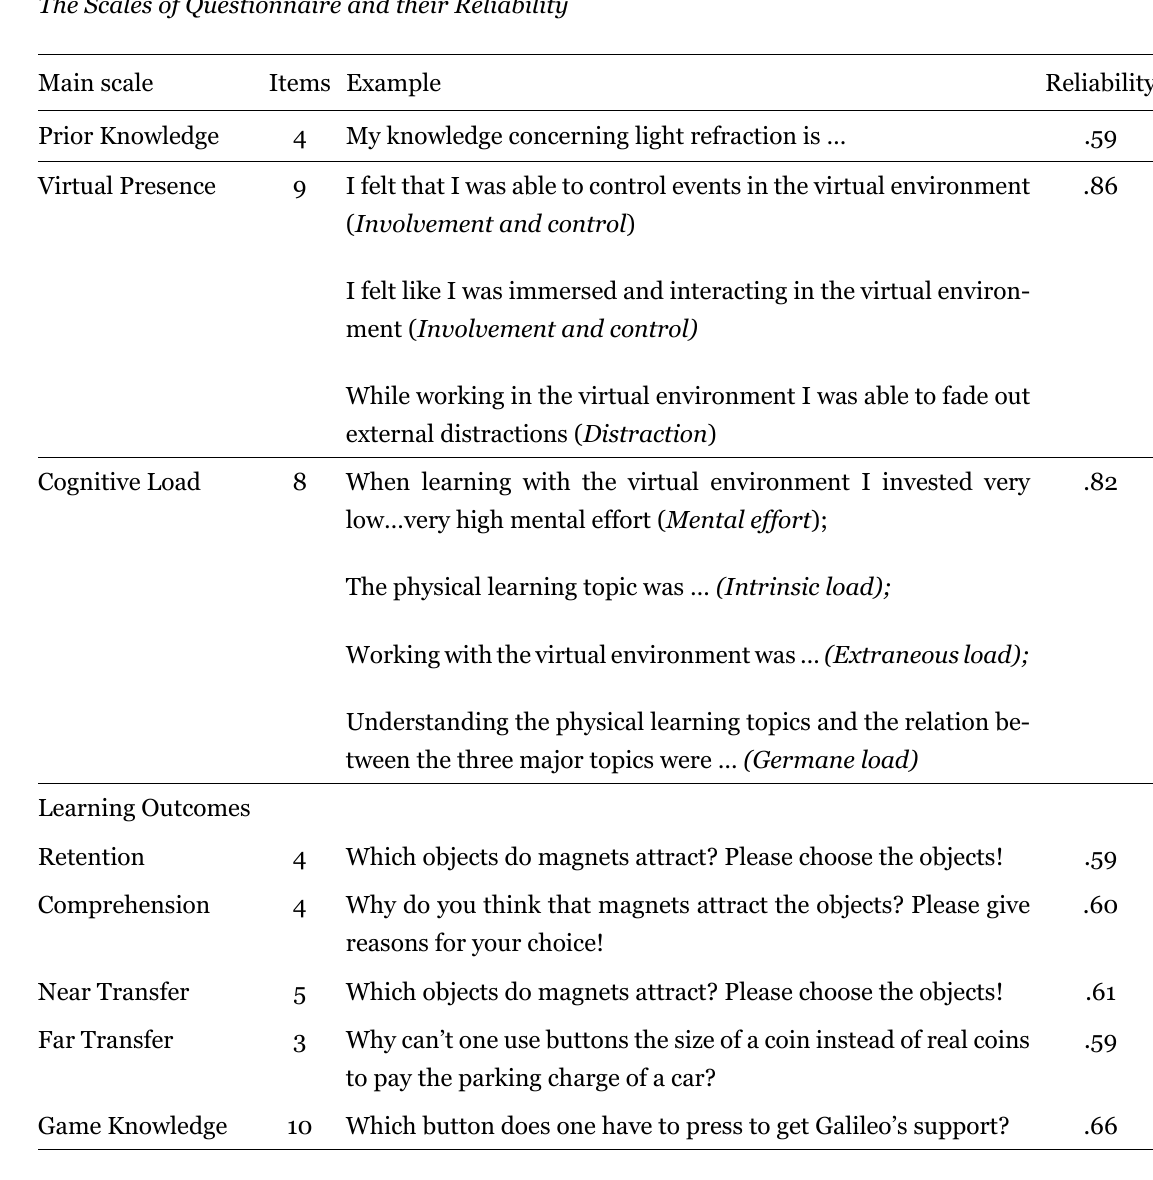
by an example of an item, and the reliability coefficients of all scales.